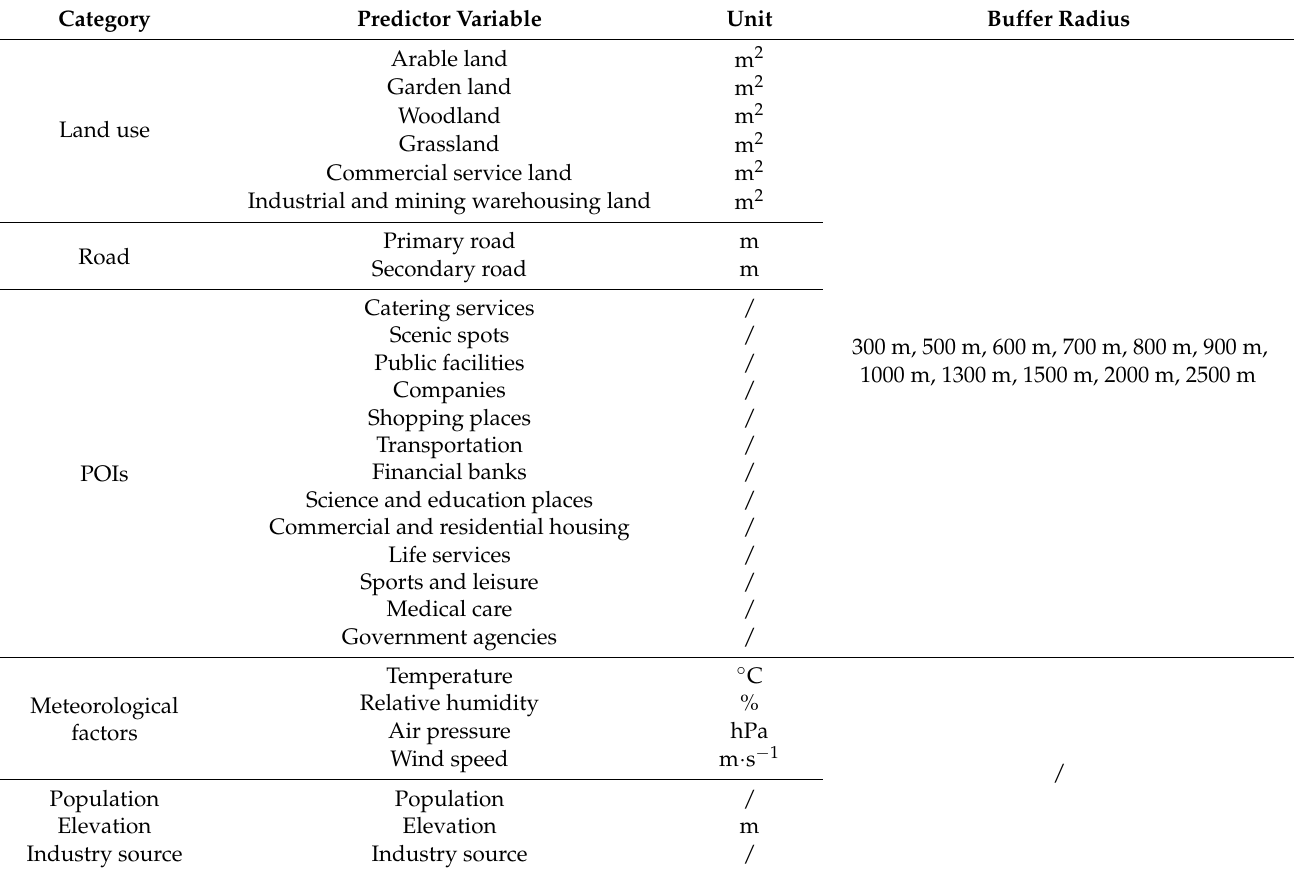
Table 1. Predictors in the LUR